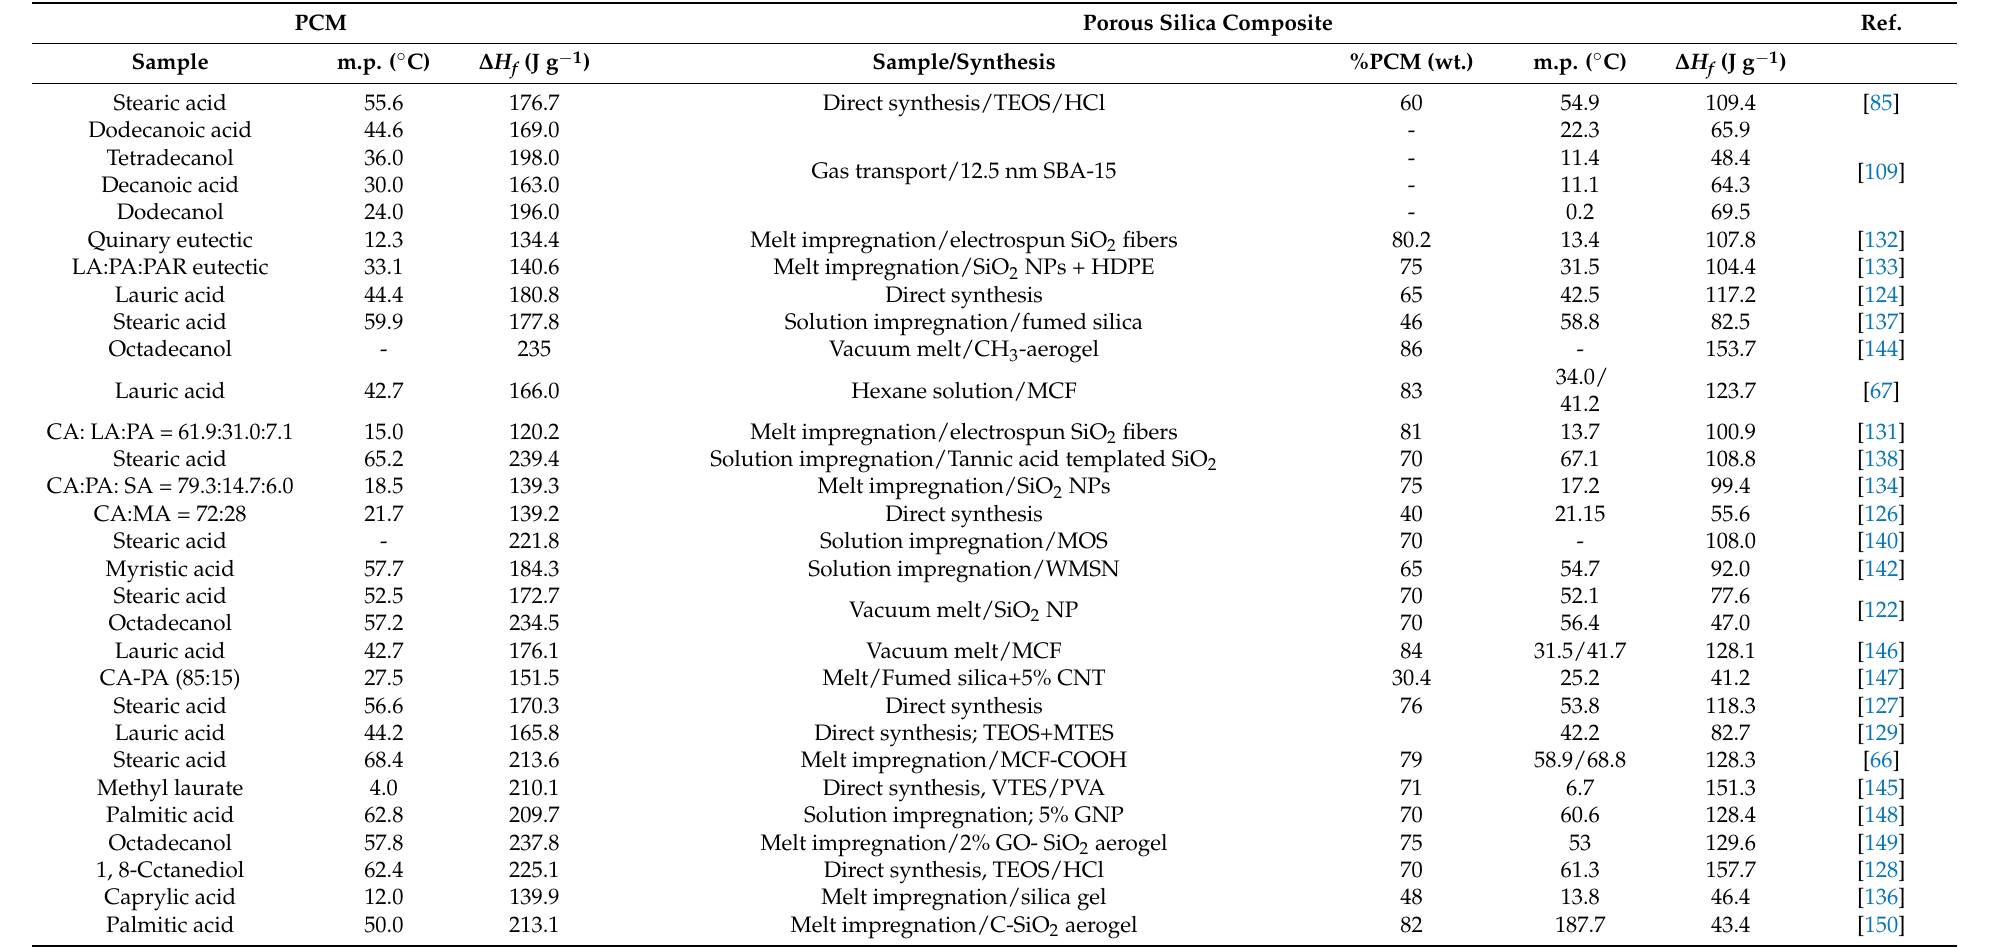
Table 4. Representative porous silica-fatty acids and derivatives nanocomposites. PCM Porous Silica Composite